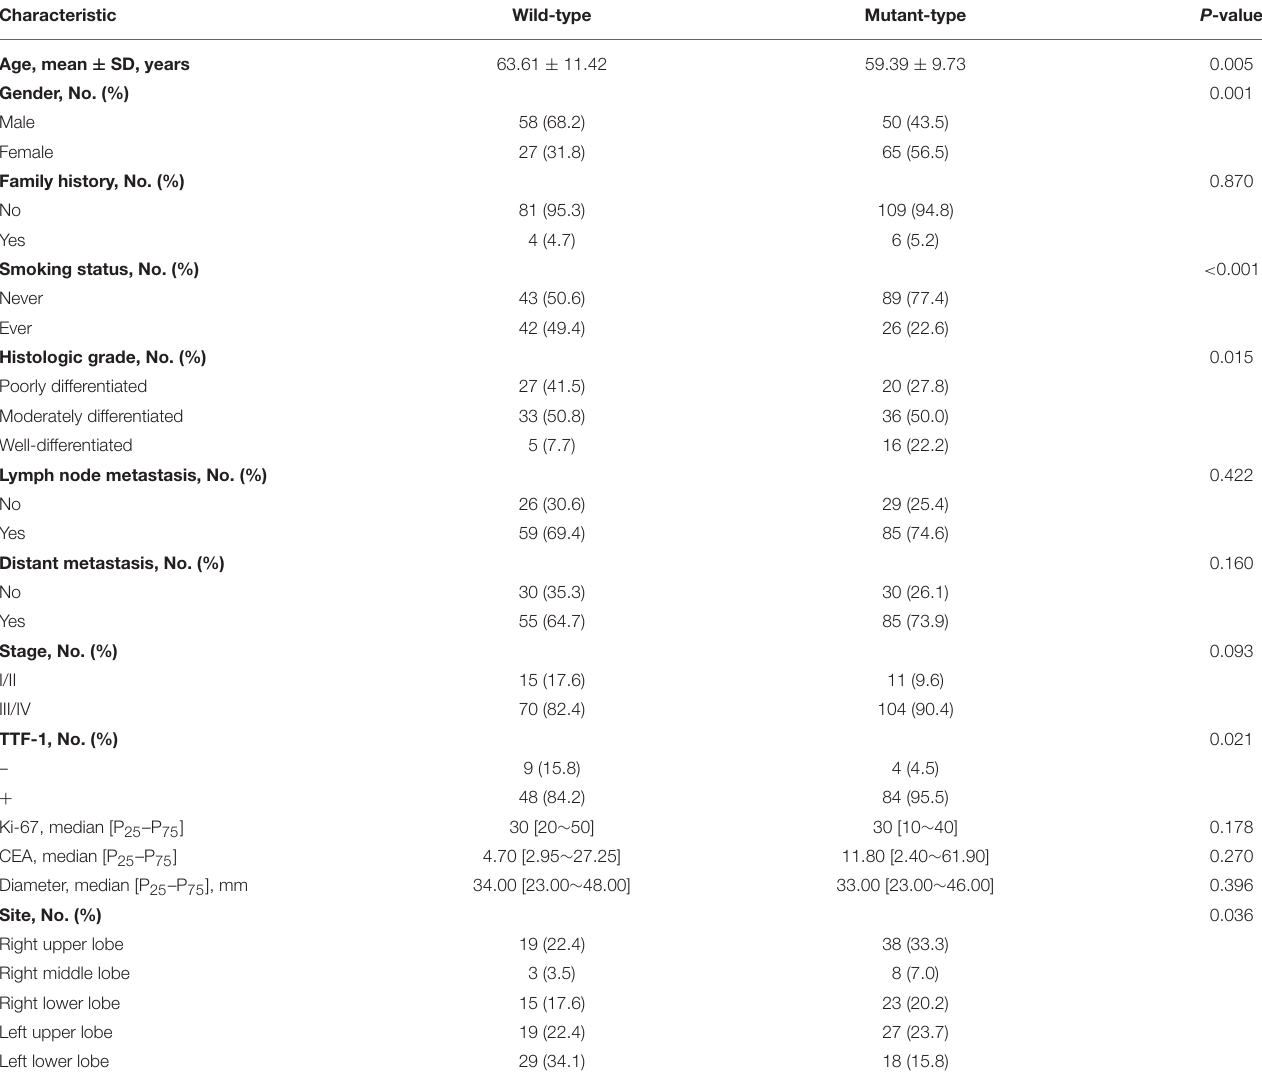
TABLE 1 | Association between clinical characteristics and the epidermal growth factor receptor mutation status in patients with lung adenocarcinoma.